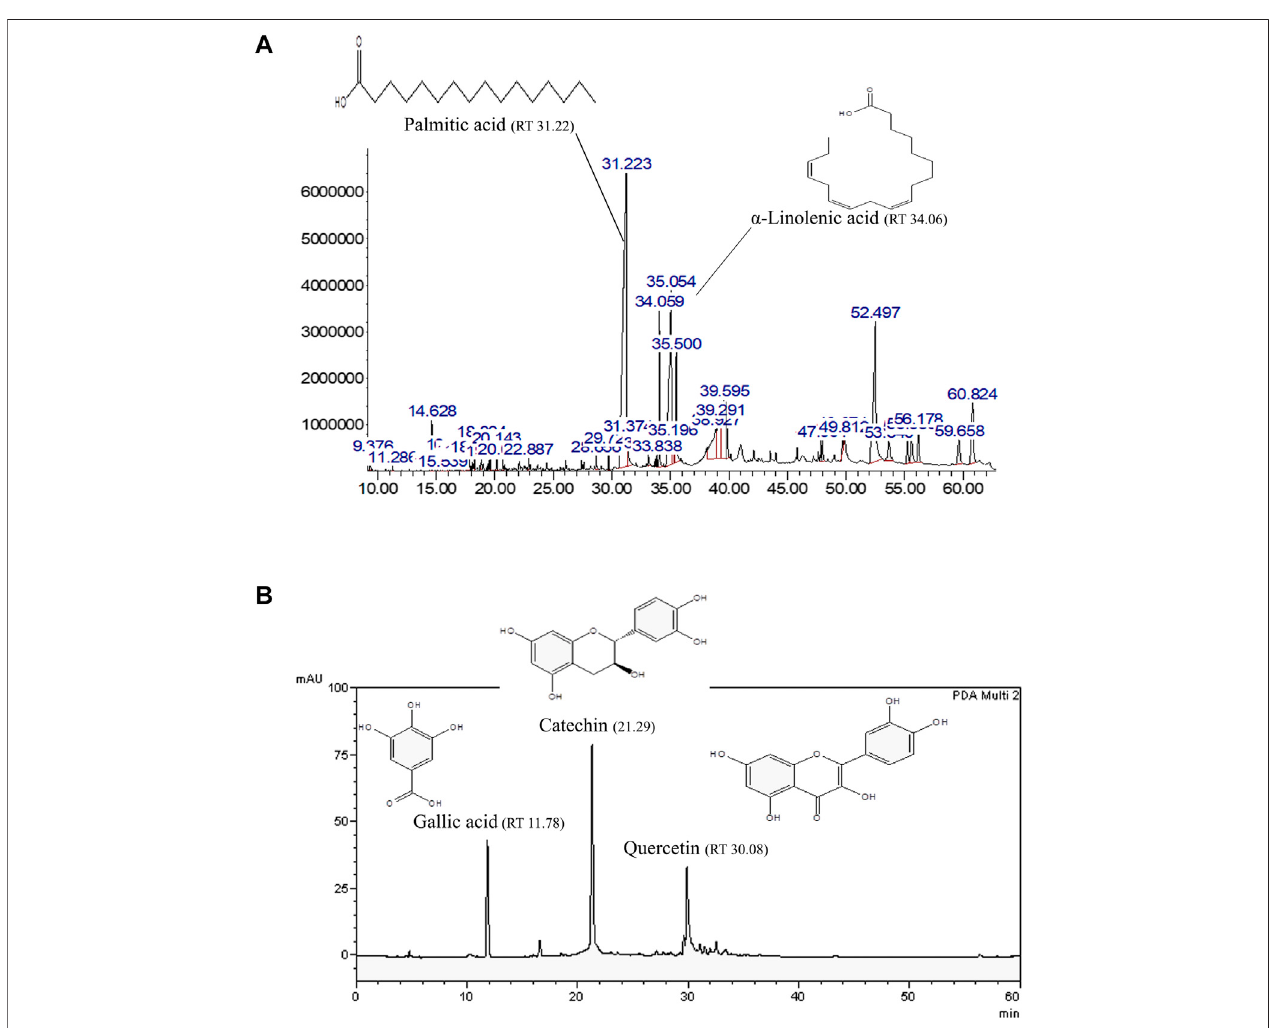
FIGURE 1 | Representative bioactive compounds in AO extracts. (A) GLC-MS pro fi le of the AO hexane extract and (B) HPLC chromatograms ofthe AO methanol extract with the chemical structures of their main constituents.